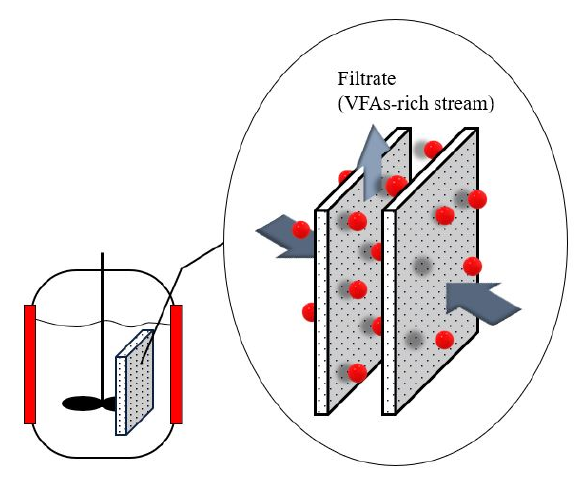
Figure 4. Anaerobic membrane bioreactor.